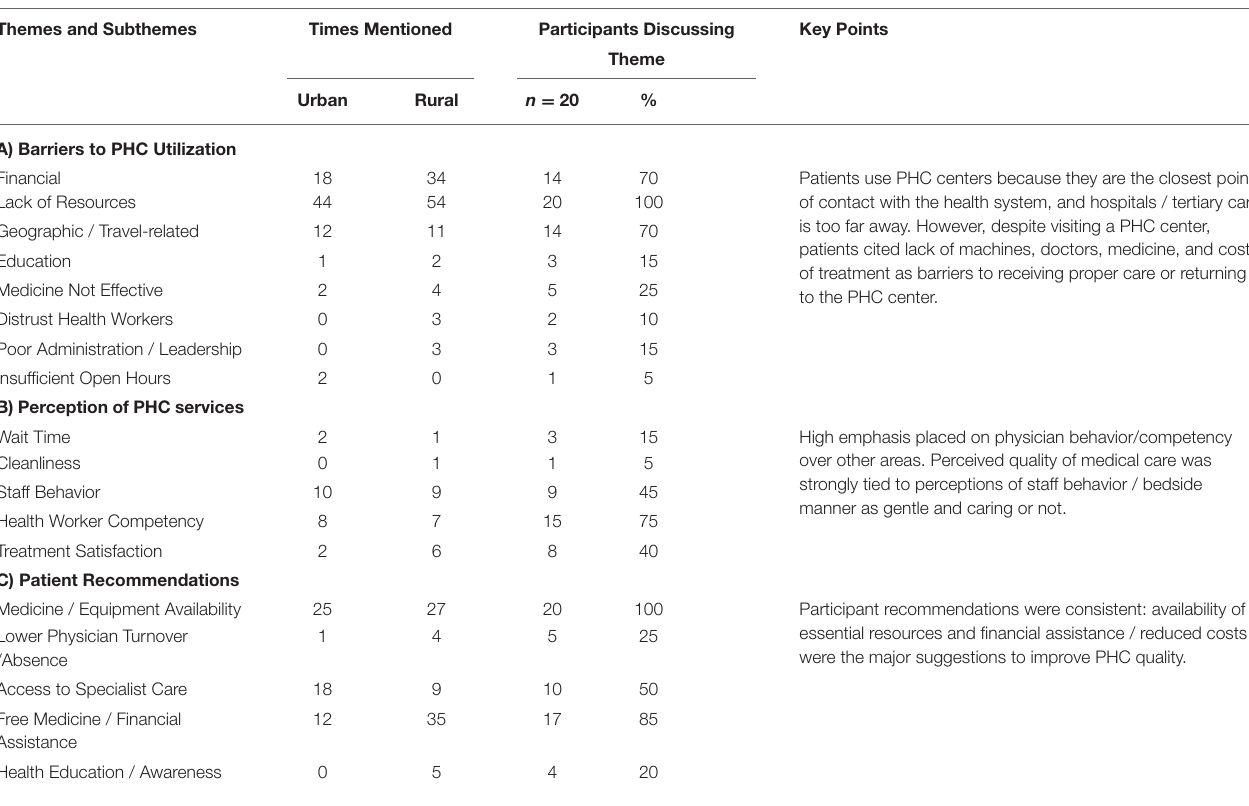
TABLE 3 | Summary of Thematic